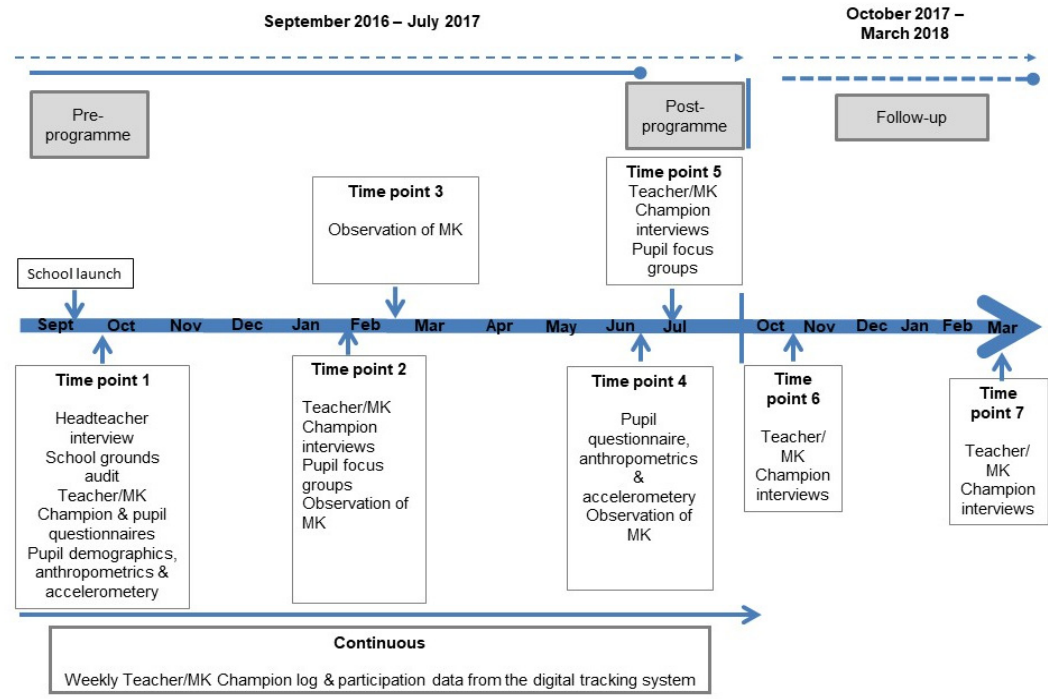
Figure 1. Time plan for the evaluation of Marathon Kids (MK).